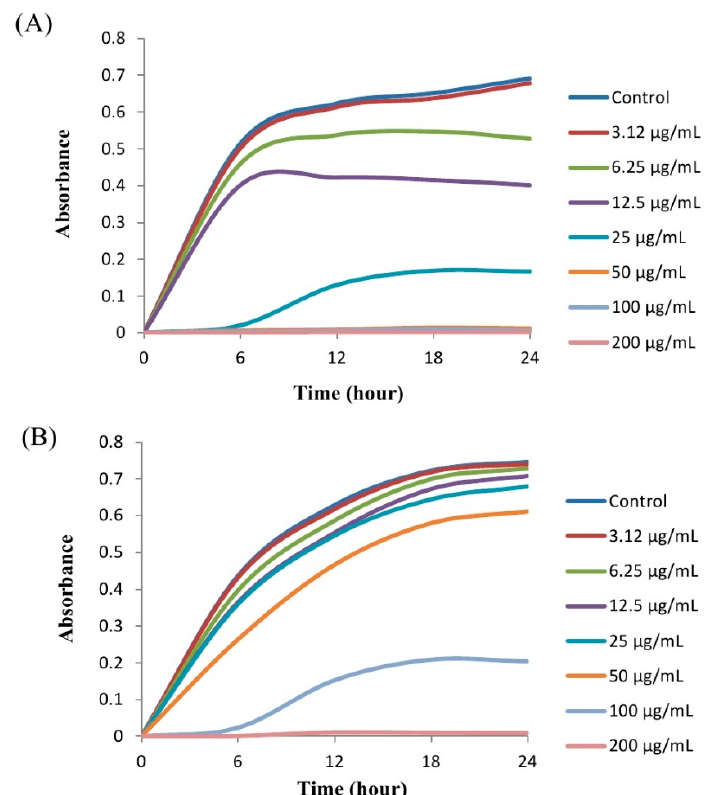
Figure 9. Growth curves of P. aeruginosa ( A ) and S. aureus ( B ) cultured in R2A broth with various concentrations of synthesized AgNPs.